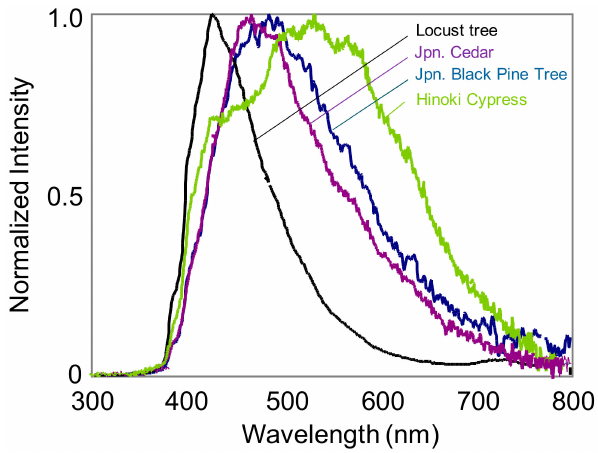
Figure 1. Fluorescence spectrum of several tree pollens excited at 355 nm.